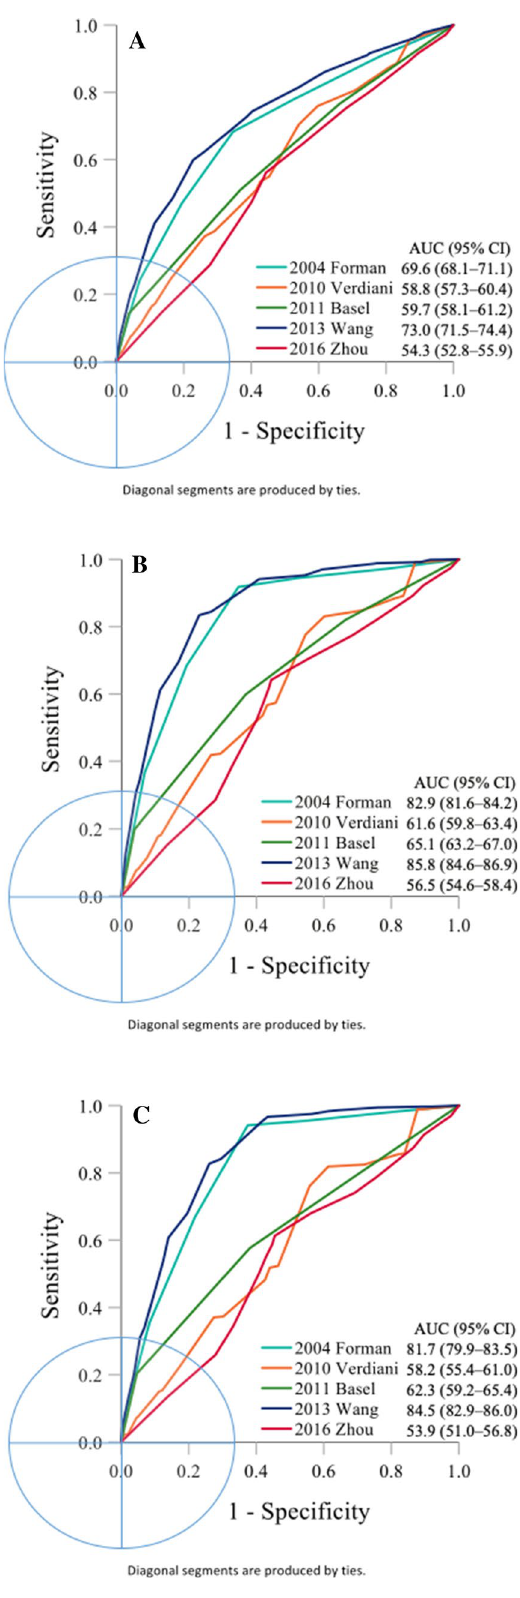
Figure 2. The discrimination ability by assessing the area under the receiver operating characteristic (AUC) curve for AKI ( A ), AKI stage 3 ( B ), and dialysis ( C ). AKI acute kidney injury; CI confidence